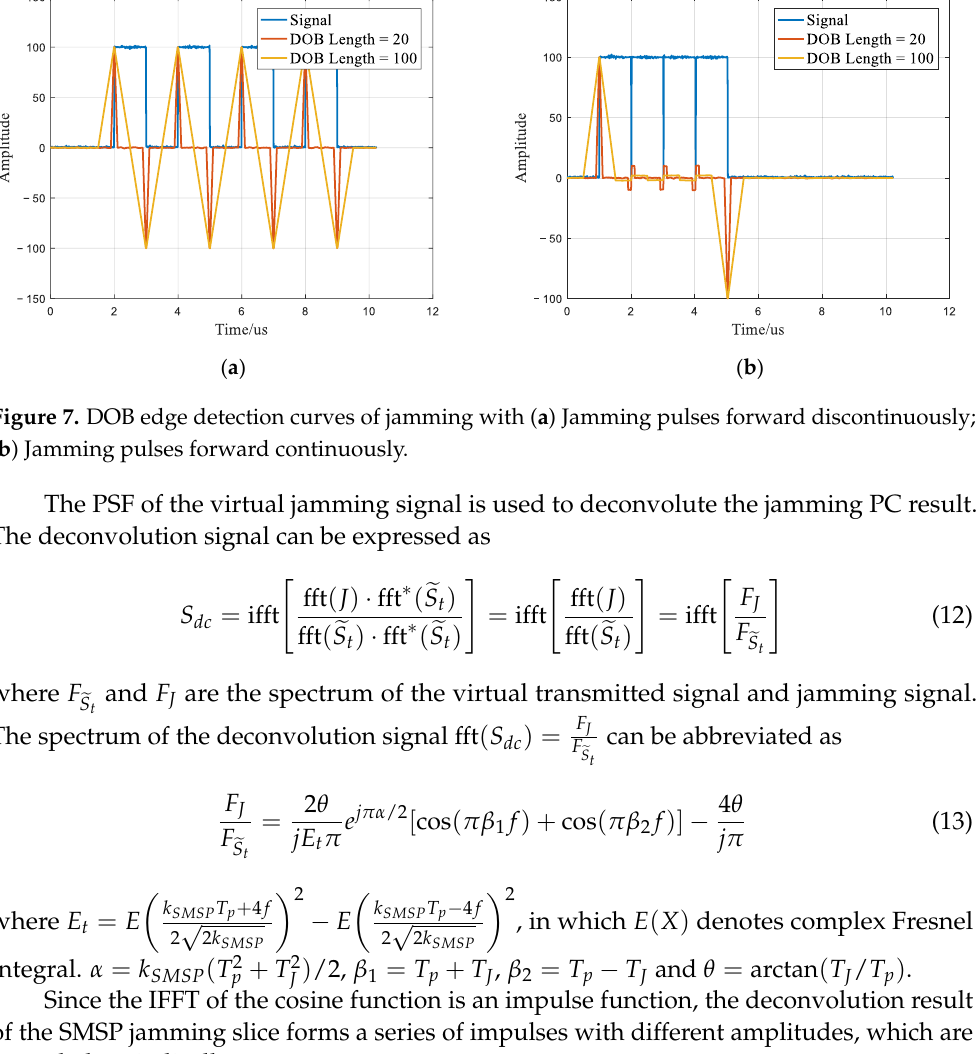
( b ) Figure 6. Influence of edge estimation error of: ( a ) Front edge; ( b ) Back edge. Different pulse edge detection methods have been studied regarding various types of radar signal. In this paper, the Difference of Box (DOB) filter [22] with STFRFT for pulse width detection is adopted since DOB is one of the most robust edge detection filters un- der Canny’s criteria and it can take the advantage of the temporal time-frequency analysis